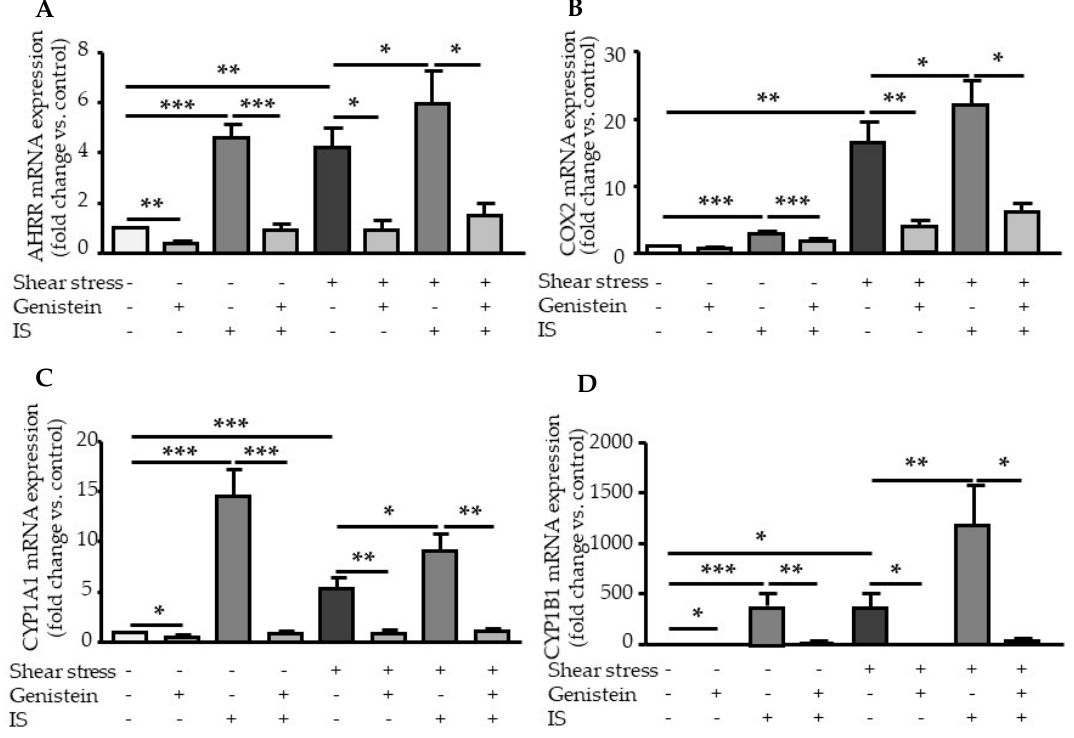
Figure 4. Genistein inhibits the induction of AHR target genes by shear stress and IS. Effect of genistein (100µM) on mRNA expression of AHRR ( A), COX2 (B), CYP1A1 ( C ), and CYP1B1 ( D ) after 4-h of shear stress (5 dynes/cm 2 ) and/or IS (200µM) stimulation. Data represent the mean ± SEM of 5 independent experiments. * p < 0.05, ** p < 0.01, *** p < 0.001.